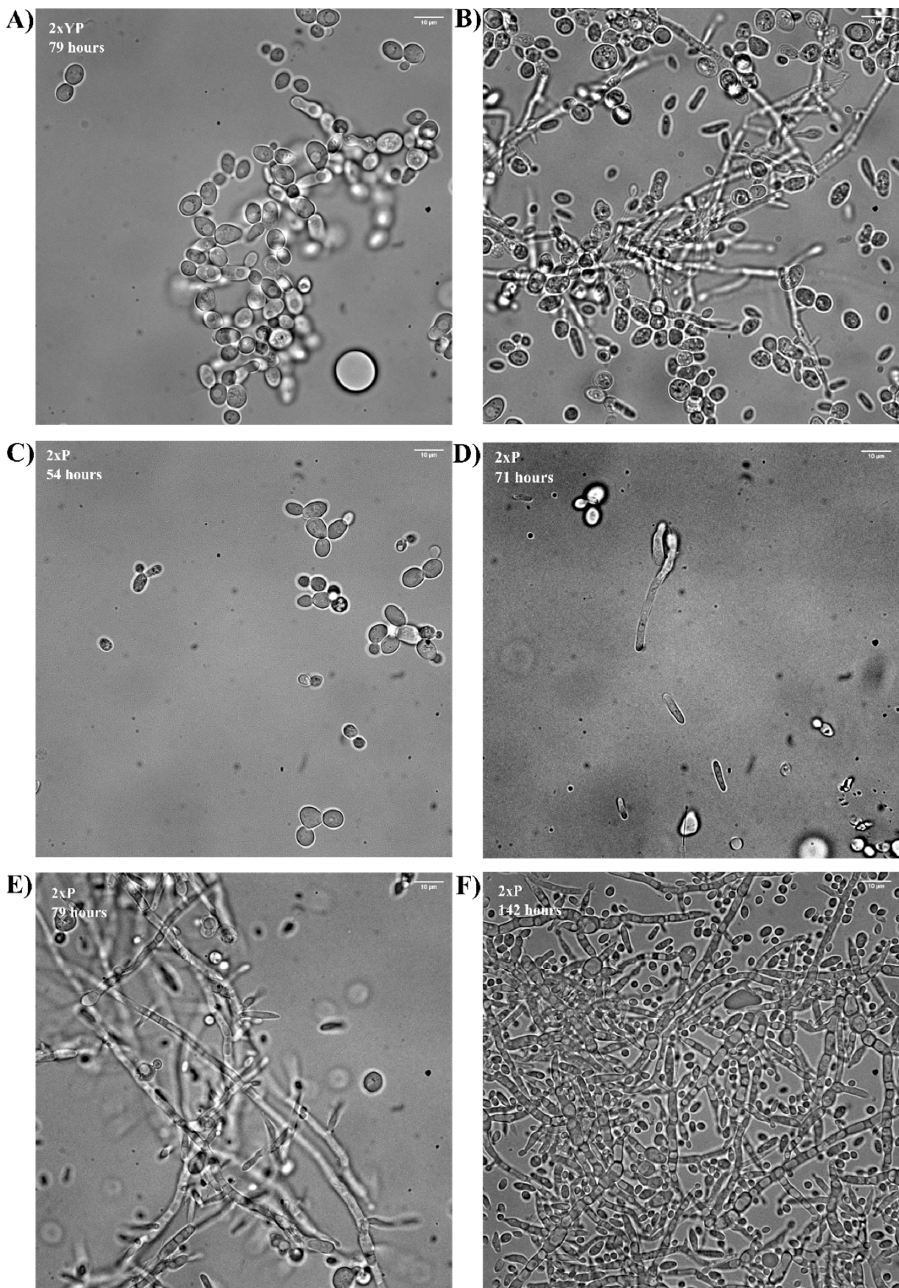
Figure 4. Microscope images taken during 2 × YP and 2 × P cultivation. Brightfield images were taken using a 100× oil immersion lens. Image taken from the 2 × YP cultivation at 79 ( A ) and 119 ( B ) hours. Images taken of the samples taken from the 2 × P cultivation at 54 ( C ), 71 ( D ), 79 ( E ) and 142 ( F ) hours, respectively.